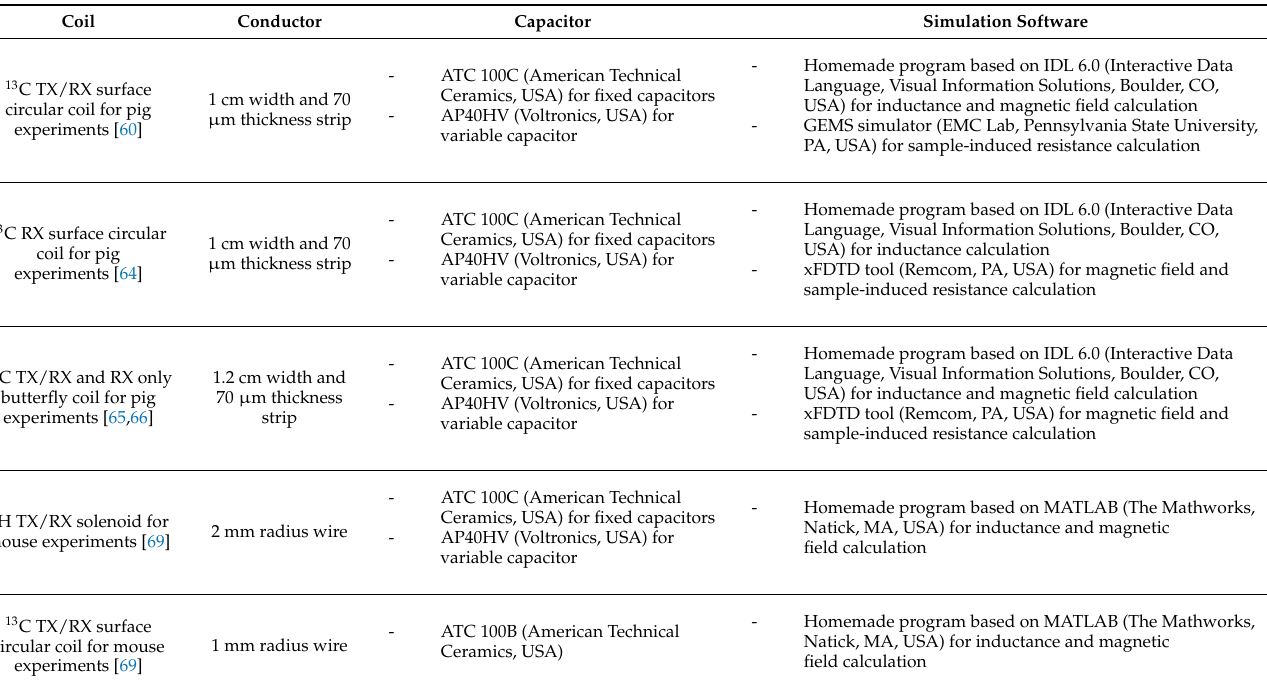
Table 3. List of equipment and methods employed for the simulation and test of the different homemade coils. The inductors of the decoupling traps were handmade by using copper wire. RG-58 coaxial cables were employed for coils connection. Workbench tests were performed by using a homemade dual-loop probe and a network analyzer HP3577 (Hewlett Packard), while MR tests were performed with a 3T GE Excite HDx (GE Healthcare, Waukesha, WI, USA)